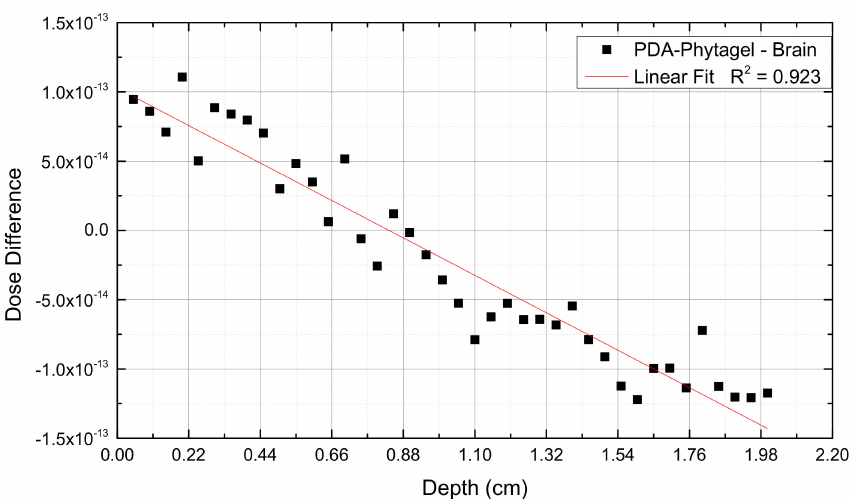
Figure 10. Dose-difference (Gy per incident photons) plot between the brain and the PDA-Phytagel dosimeter achieved by the subtraction of both